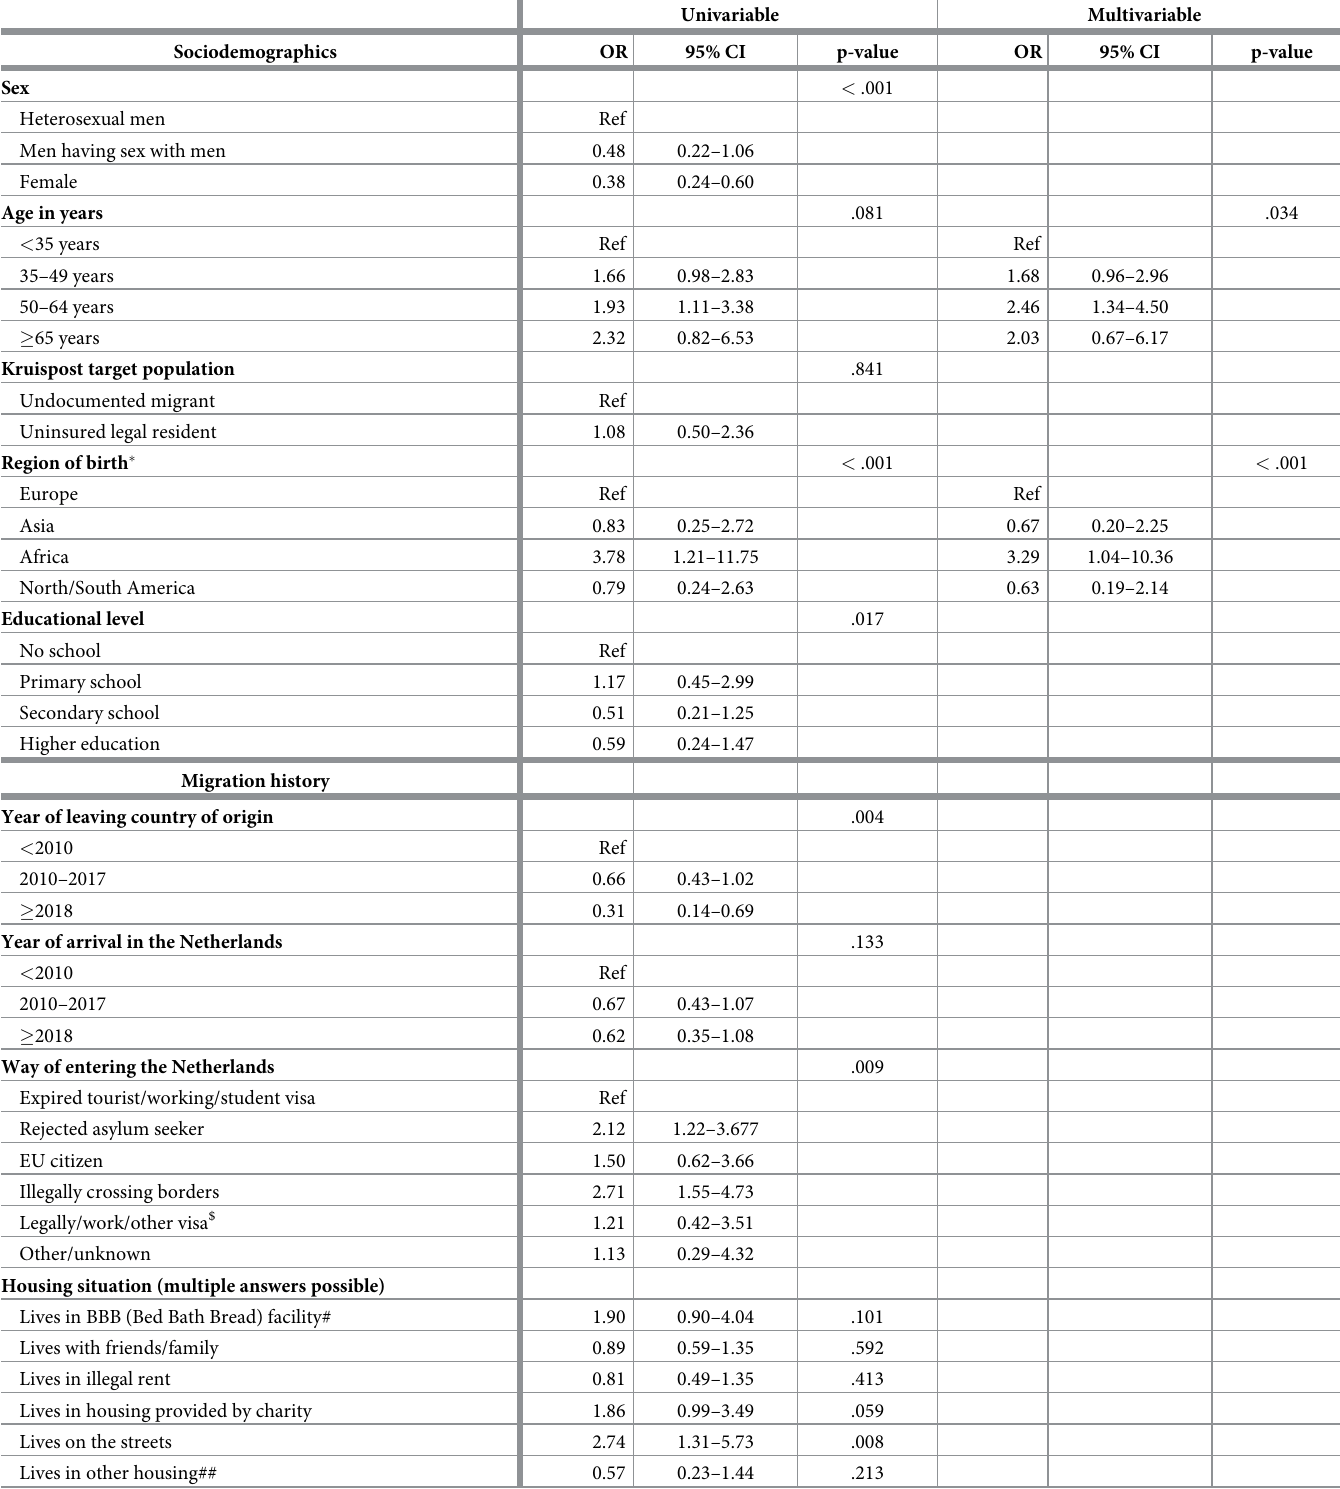
Table 4. Determinants of HBV exposure among undocumented migrants and uninsured legal residents that were tested for HBV (n = 130/438) in Amsterdam, the Netherlands, October 2018—October 2019 (univariable and multivariable logistic regression